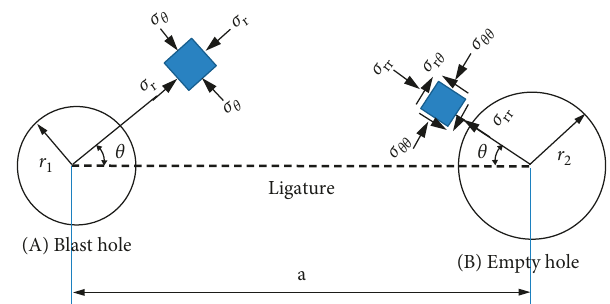
Figure 1: The stress concentration effect of an adjacent empty